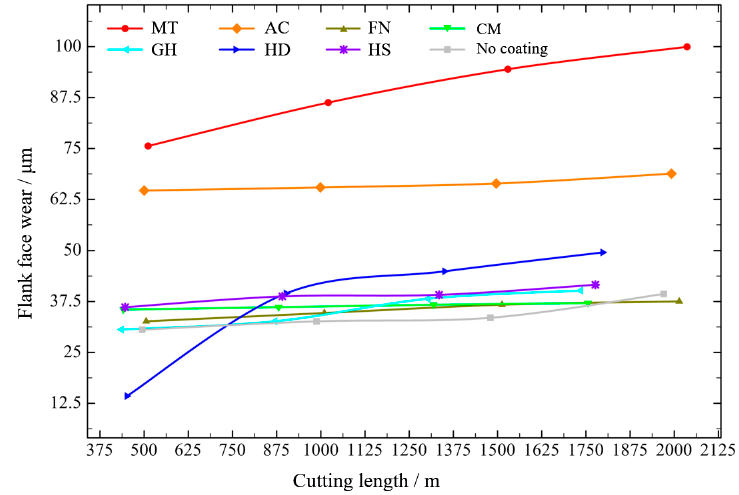
Figure 14. Tool flank face wear of different coatings at low speed.